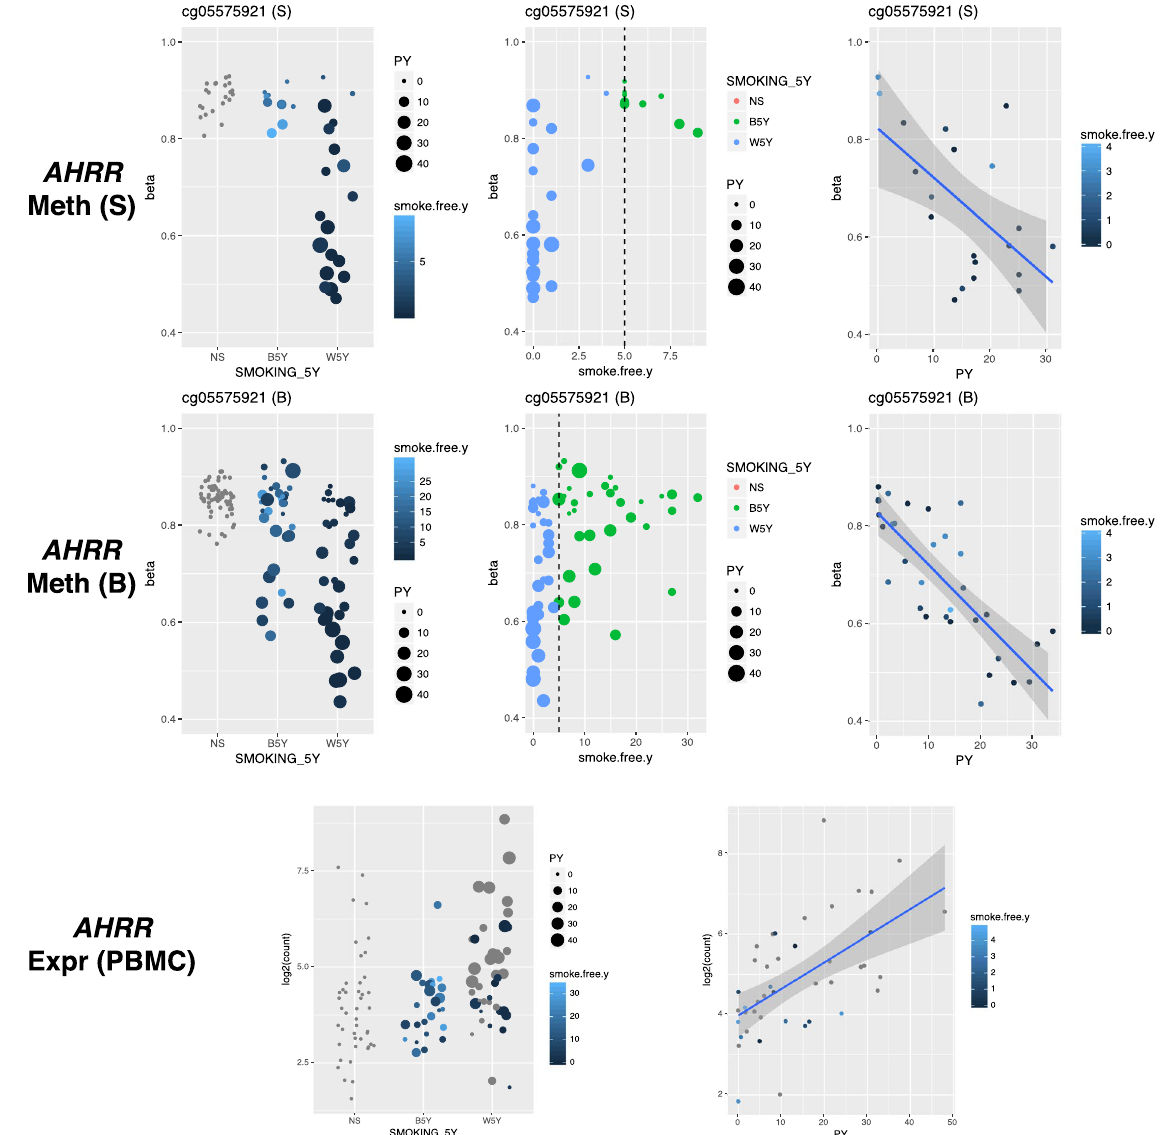
Figure 5. The effect of smoking is proportional to the smoking load and decrease as time since smoking cessation increase. DNA methylation is shown for the cg05575921 site, separately for the S and B cohorts. Methylation levels ( β values) are shown in relation to the NS, B5Y and W5Y smoking categories (left panels), the time since smoking cessation (middle panels), and the Pack-Years (PY) in the W5Y group only (right panels). AHRR gene expression levels are shown for the PBMC cohort as normalized counts, in relation to the NS, B5Y and W5Y smoking categories and the Pack-Years in the W5Y group. Grey dots correspond to individuals in the W5Y group that were actively smoking at the date of sampling in the PBMC